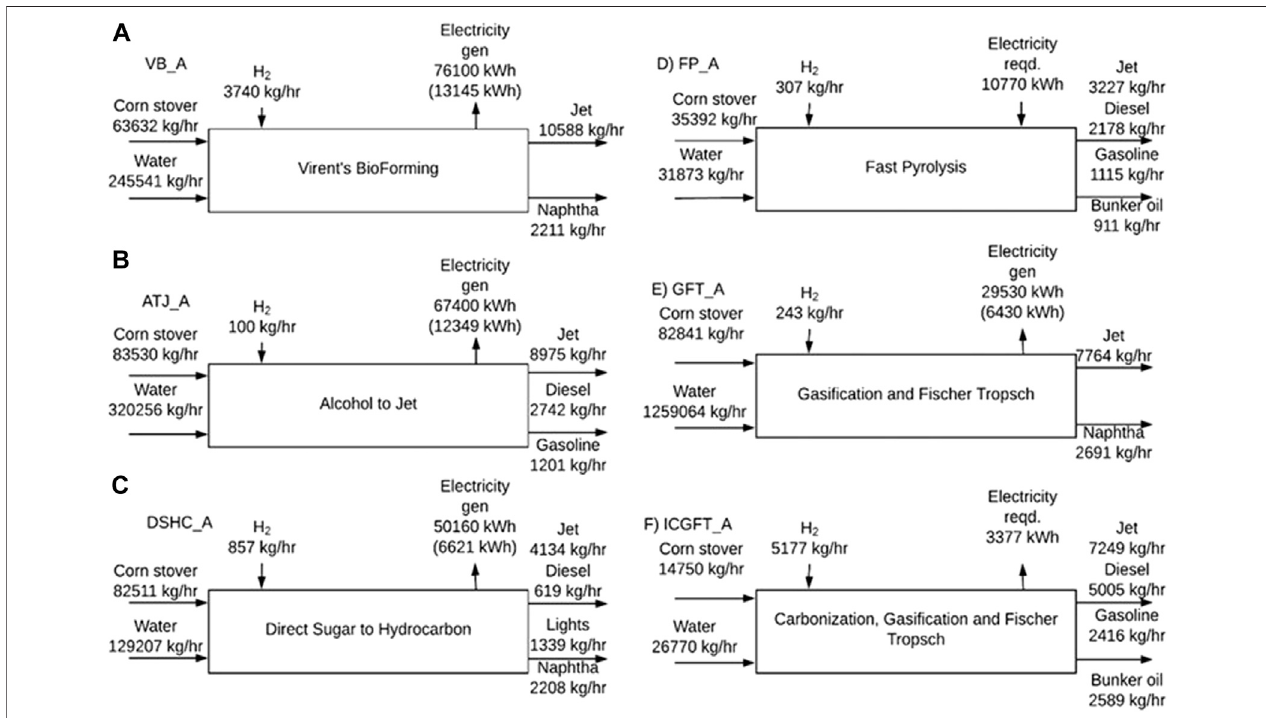
FIGURE 3 | Mass and energy fl ow in the corn stover-based SAF standalone scenarios.